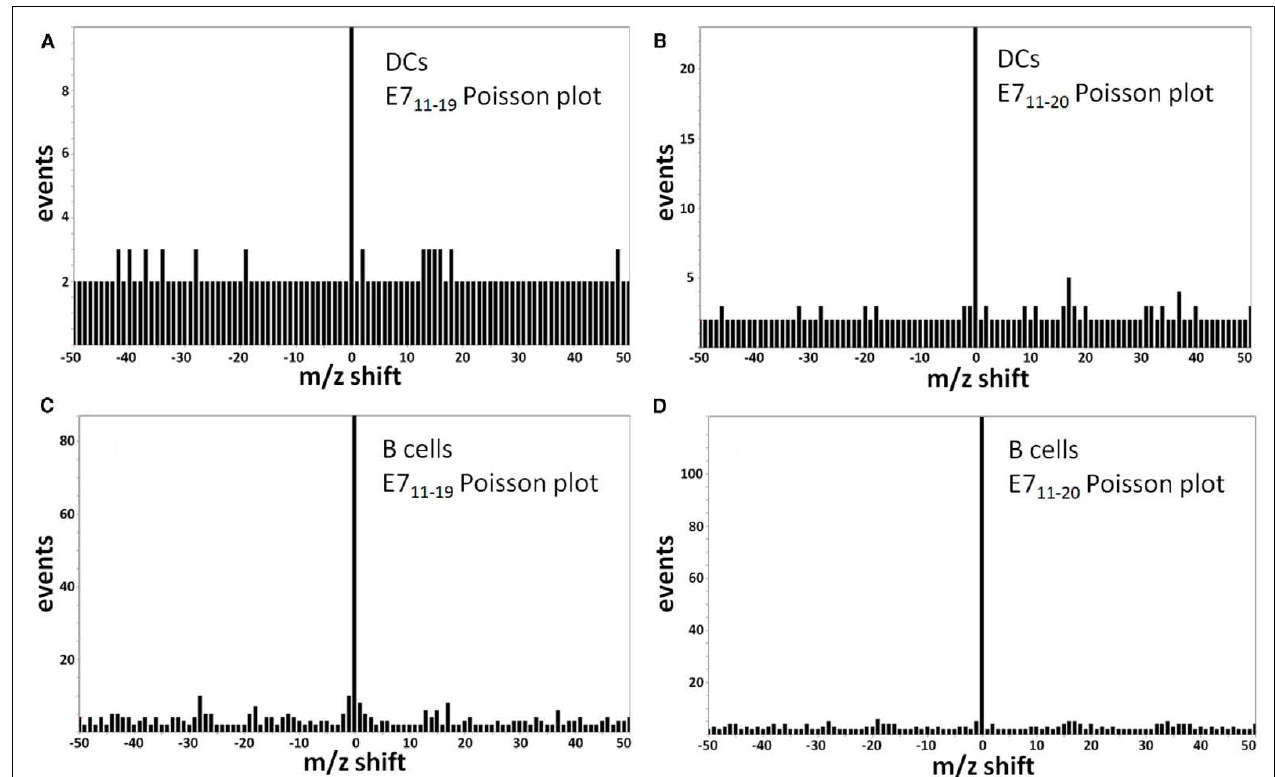
plot of the MS 3 605.8/764.4 spectrum (for E7 11–20 ) of peptides recovered from moDCs.The A, B pair were collected as averages over the sequence A, B, A, B, ... so their intensities can be directly compared. (C) Poisson detection of the MS 3 555.3/764.4 spectrum (for E7 11–19 ) of peptides recovered from B cells; (D) Poisson detection of the MS 3 605.8/764.4 spectrum (for E7 11–20 ) of peptides recovered from B cells.The C, D pair can also be directly